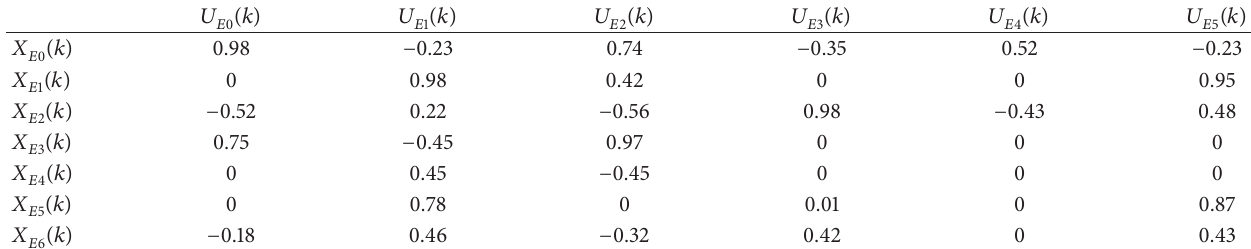
of the sensitivity of internal stimuli. YF